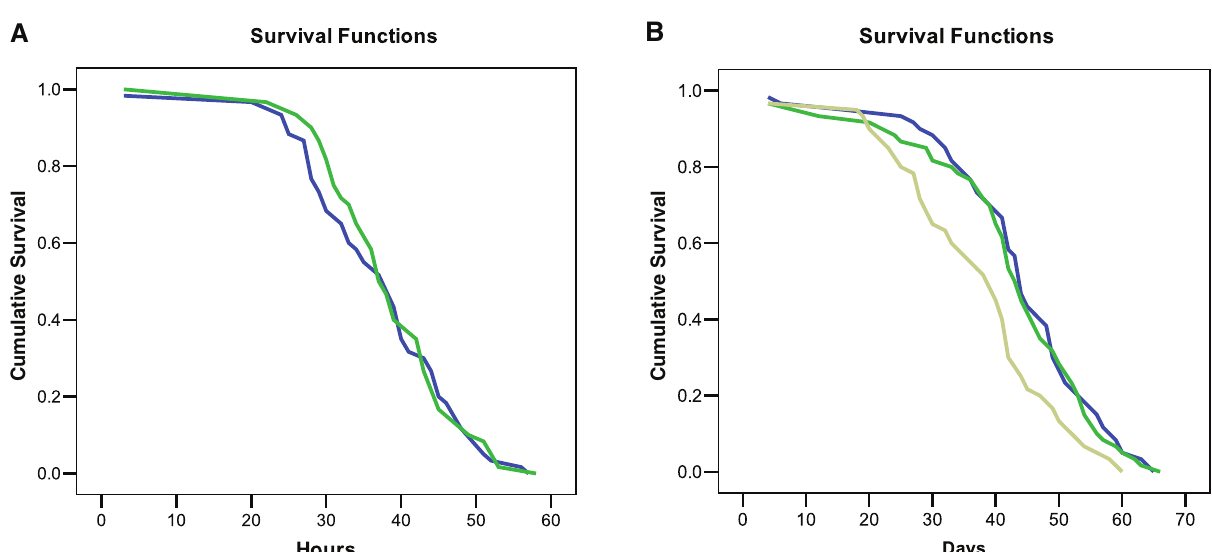
Figure 3. A : Cumulative survival of healthy bees fed with a sucrose solution with (blue line) or without (green line) nicotine and starved. B : Cumulative survival of healthy bees that received a daily diet of sucrose solution with (beige line), or without nicotine (blue line), or a single dose of nicotine on day one (green